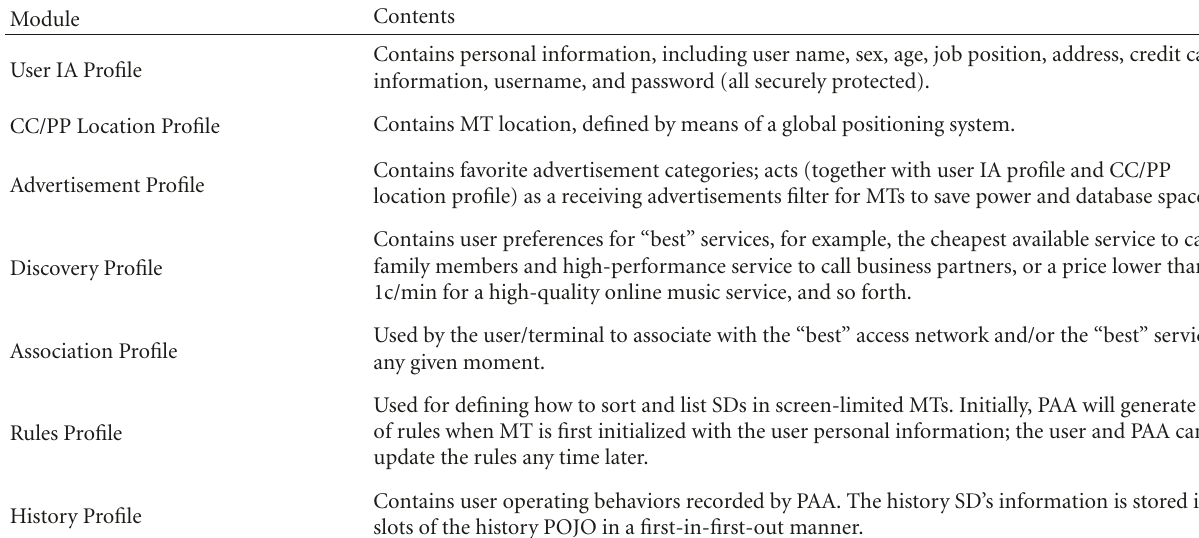
Table 2: The iWBC User Profile’s General